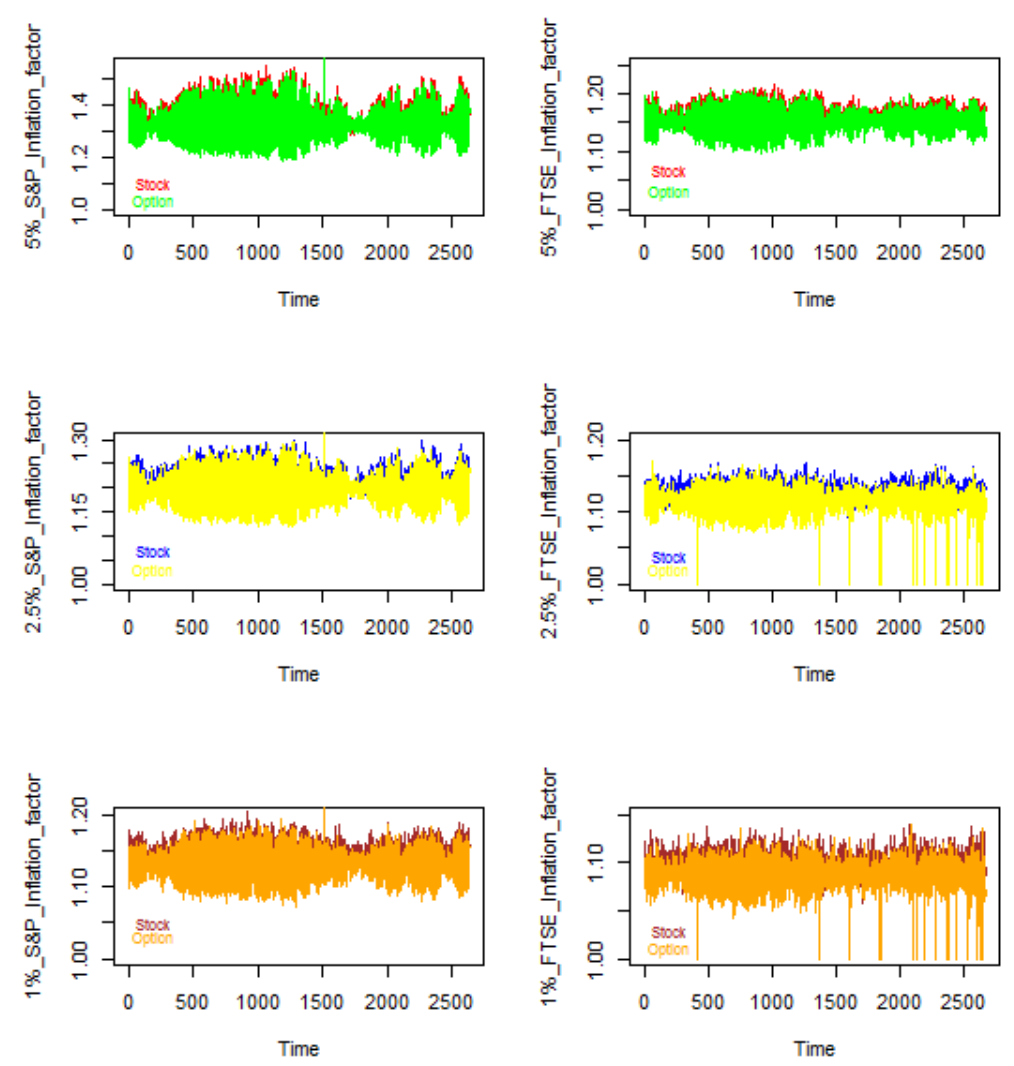
Figure 6. Variation of 15-day Inflation factor with time. Note: The figure shows the variation in 15-day MaxVaR to VaR ratio with repect to time, for S&P 500 stock returns and FTSE 100 stock returns and the P&L of the corresponding 30-day index options at various significance levels.